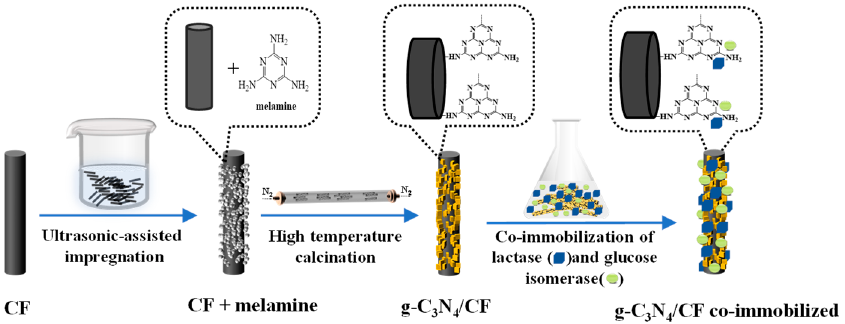
Figure 1. Preparation process diagram of the g-C 3 N 4 /CF composite carriers for co-immobilization. The acetone-treated CF was ultrasonically impregnated in melamine saturated solution for 1 h,